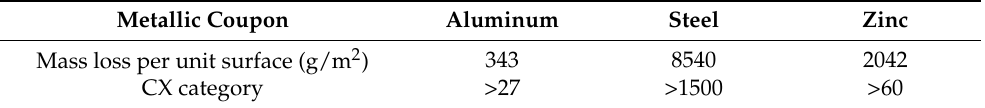
Table 2. Mass loss on corroded coupon samples compared with the CX corrosivity category. Metallic Coupon Aluminum